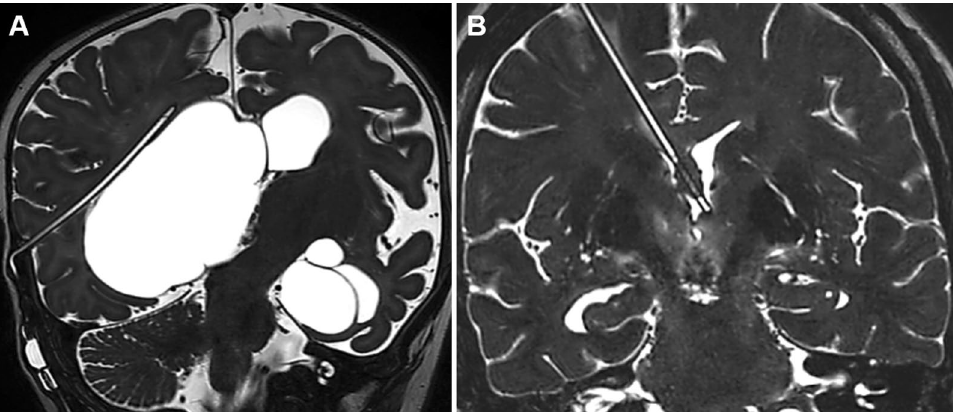
Fig. 9 Reconstructed 3D‑DRIVE in coronal oblique planes, A A 9‑month‑old asymptomatic boy, yet the clinical examination of his shunt showed poor filling of the reservoir, shows extraventricular migration of the proximal catheter. B A 36‑year‑old female patient presented with fluctuating conscious level, shows embedded proximal catheter (terminal 2 cm) within septum pellucidum and shows intraluminal dark